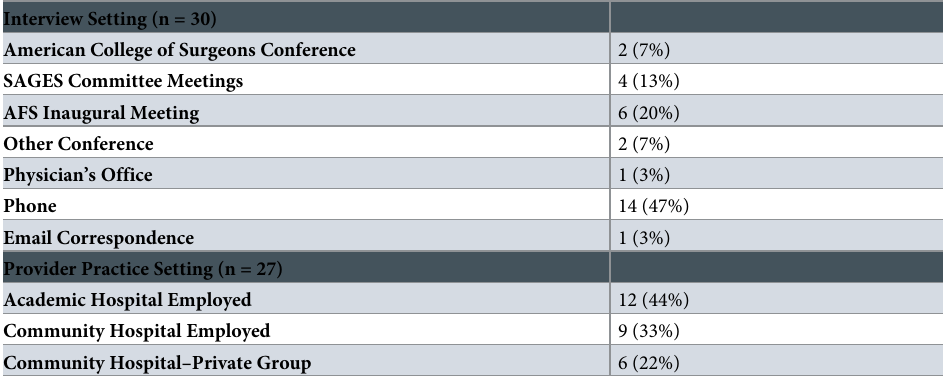
Table 2. Additional interview